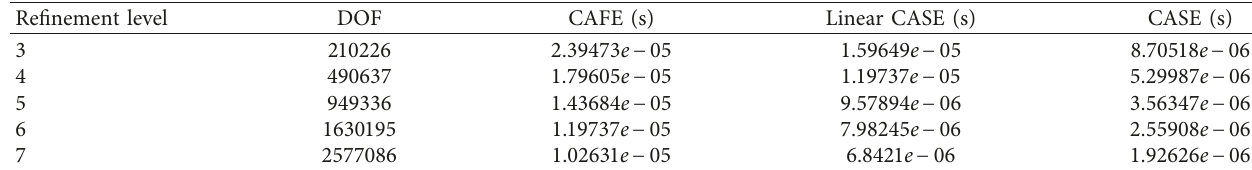
Figure 9: Comparison of structural response of in-house FSI framework and Abaqus/Explicit. (a) Point 1646. (b) Point Table 3: DOF and time increment (s) of different refinement levels.